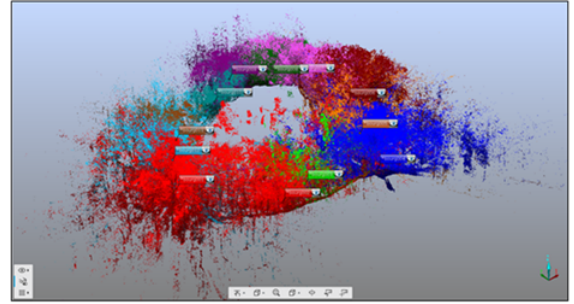
Figure 4: First scanning campaign around the castle’s ruins A second campaign (Figure 5) of laser scanning measurements was carried out in later autumn. Six complementary scans were carried out in direct proximity to the castle walls (inside and outside), with the aim of modelling the already visible ruins. This series of scans were also directly georeferenced on spheres placed on known points.